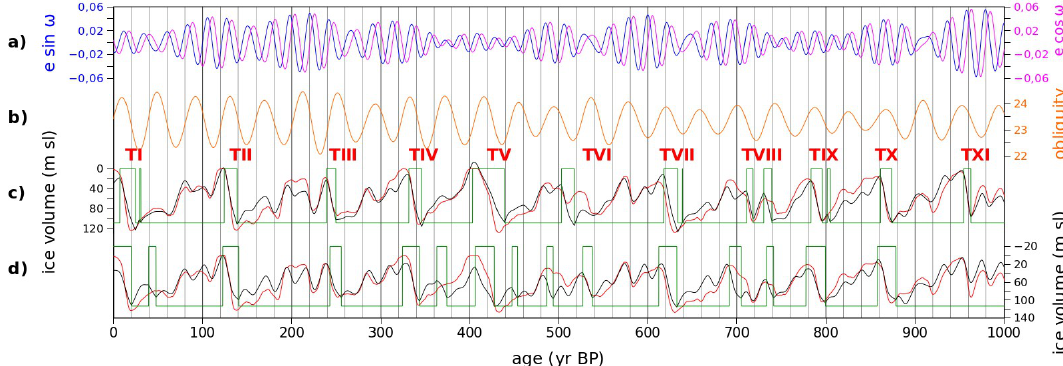
Fig. 6. Model orbital forcings (Laskar et al., 2004), ice volume data (Bintanja et al., 2005), and model experiments. Terminations are marked with red roman numbers. From top to bottom: (a) precession parameters e sin ω and e cos ω . (b) Obliquity parameter. (c) Red: ice volume data; Black: Best-wo model experiment, without obliquity influence on deglaciation trigger; Green: model state. (d) Red: ice volume data; Black: Best-wp model experiment without precession influence on deglaciation trigger; Green: model